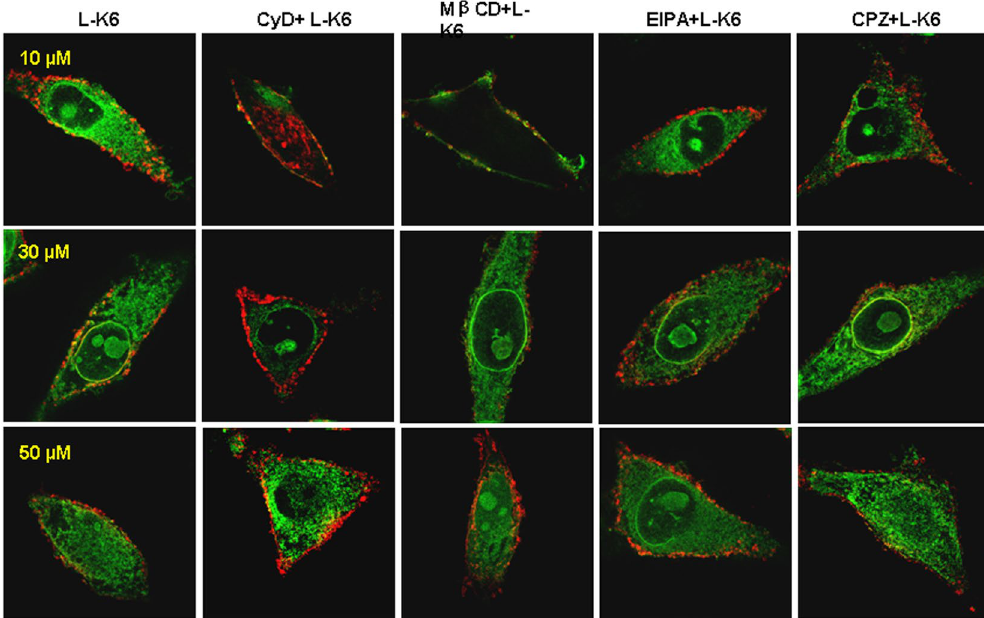
Figure 5. Cellular uptake of L-K6 by MCF-7 cells was partially blocked by endocytosis inhibitors, as assessed by 3D-SIM super-resolution microscopy. Pre-incubation with cytochalasin D (CyD) dramatically blocked the internalization of L-K6 at 10–30 μ M. Similar inhibitory effect was observed in cells pretreated with methyl- β - cyclodextrin (M β -CD), a membrane cholesterol depleting agent and caveolae-mediated endocytosis inhibitor. Interestingly, this effect was much more sensitive to 10–30 μ M L-K6. Additionally, ethylisopropylamiloride (EIPA) significantly decreased fluorescence derived from FITC-L-K6 (particularly at 50 μ M). In contrast, chlorpromazine (CPZ), a clathrin-dependent endocytosis inhibitor, showed no effect on cellular uptake of